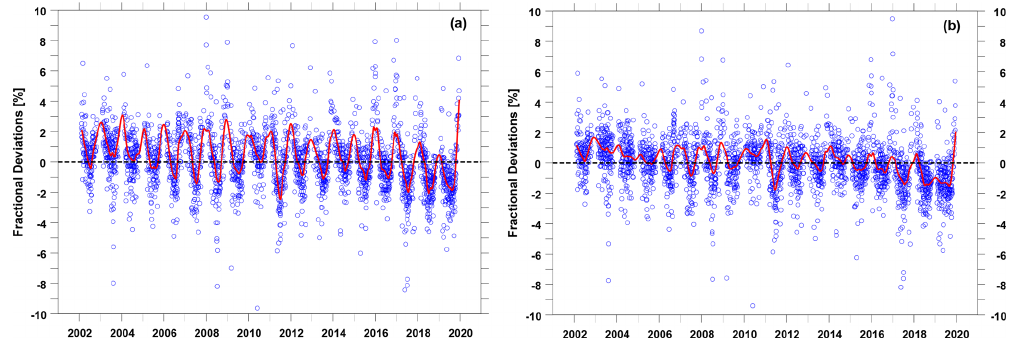
Figure 7. The differences between the Brewer and Dobson TCO 3 daily means as a percentage of the Dobson TCO 3 value: original data after application of the correction function, according to Eq. (1), to the Dobson ZS data (a) and the Dobson and Brewer TCO 3 corrected for the effective temperature (b) . The red curve represents the smoothed pattern by the LOWESS filter.